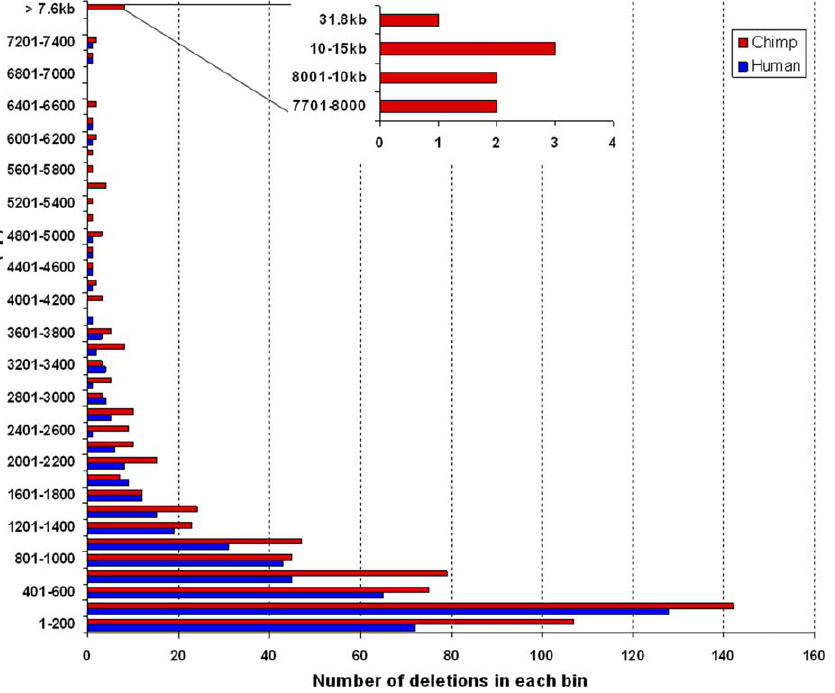
Figure 1. Size Distribution of Chimpanzee-Specific ARMD Events Size distribution of chimpanzee-specific ARMD events (red bars) compared with that of human-specific ARMD events (blue bars), displayed in 200-bp bin sizes.